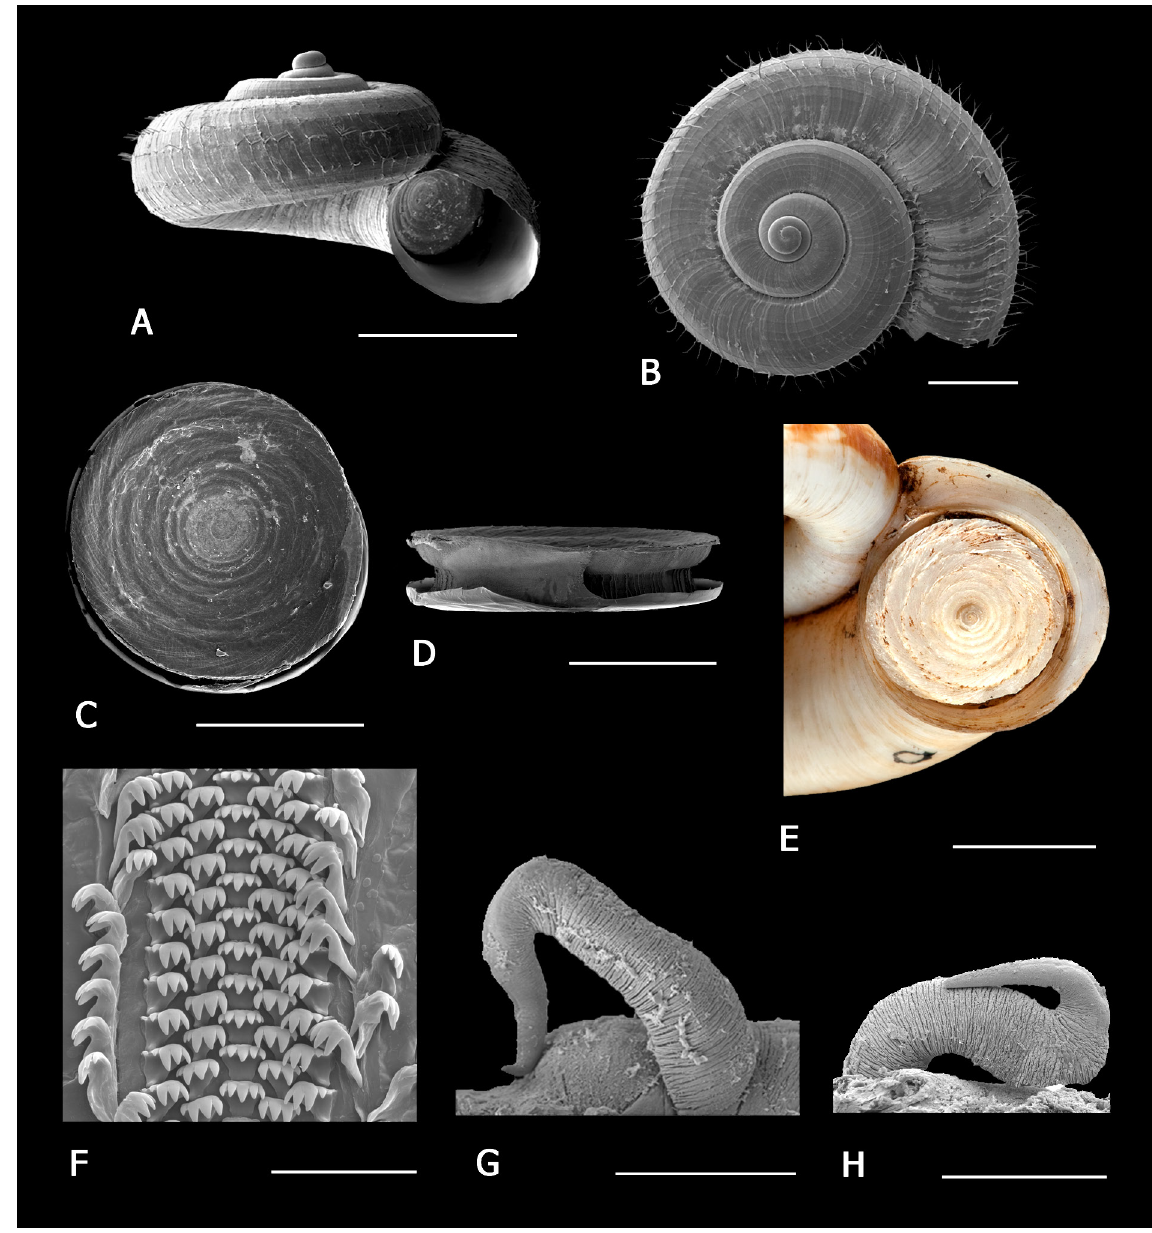
Fig. 36. Cyclotus sp. A . Aperture view (NMSA L7108). B. Dorsal view (NMSA L7108). C–D . Operculum (NMSA L7108). E . Cyclotus variegatus Swainson, 1840 operculum (NHMUK1893.6.7.43-5). F . Portion of radula (NMSA L7108). G . Penis, dorsal view (NMSA L7108). H . Penis lateral view (NMSA L7108). Scale bars: A–B = 2 mm; C, E = 1 mm; D, G–H = 500 µm; F = 50